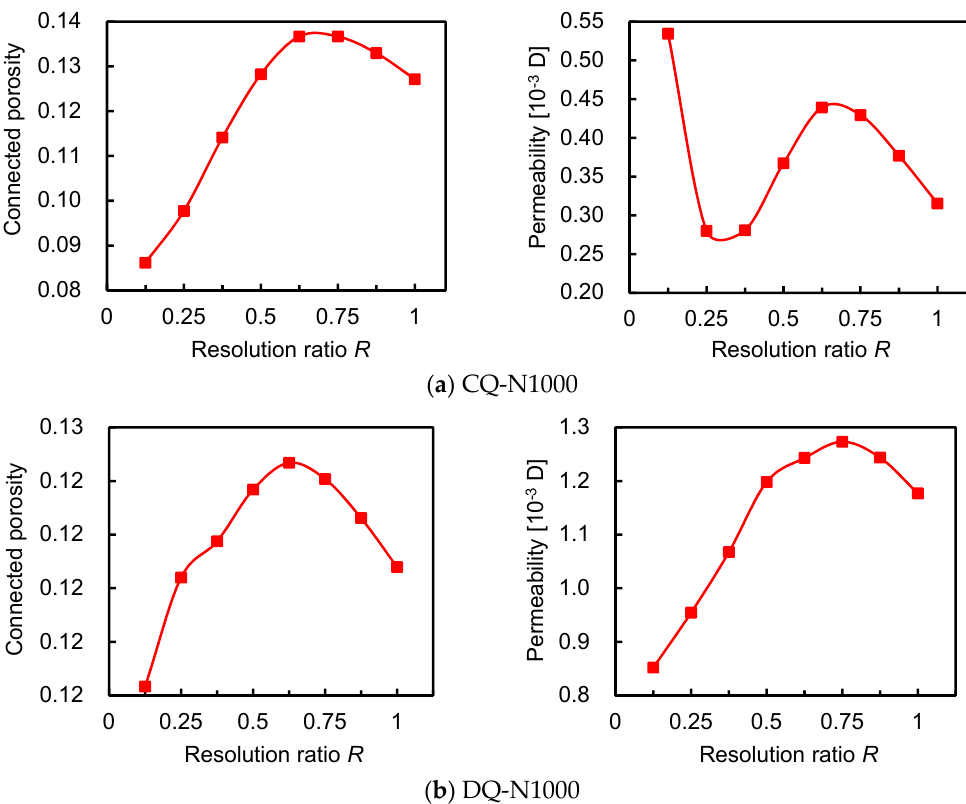
Figure A1. Resolution effect on connected porosity and calculated permeability at N = 1000 sample size with Huang’s algorithm used in coarsening operation.